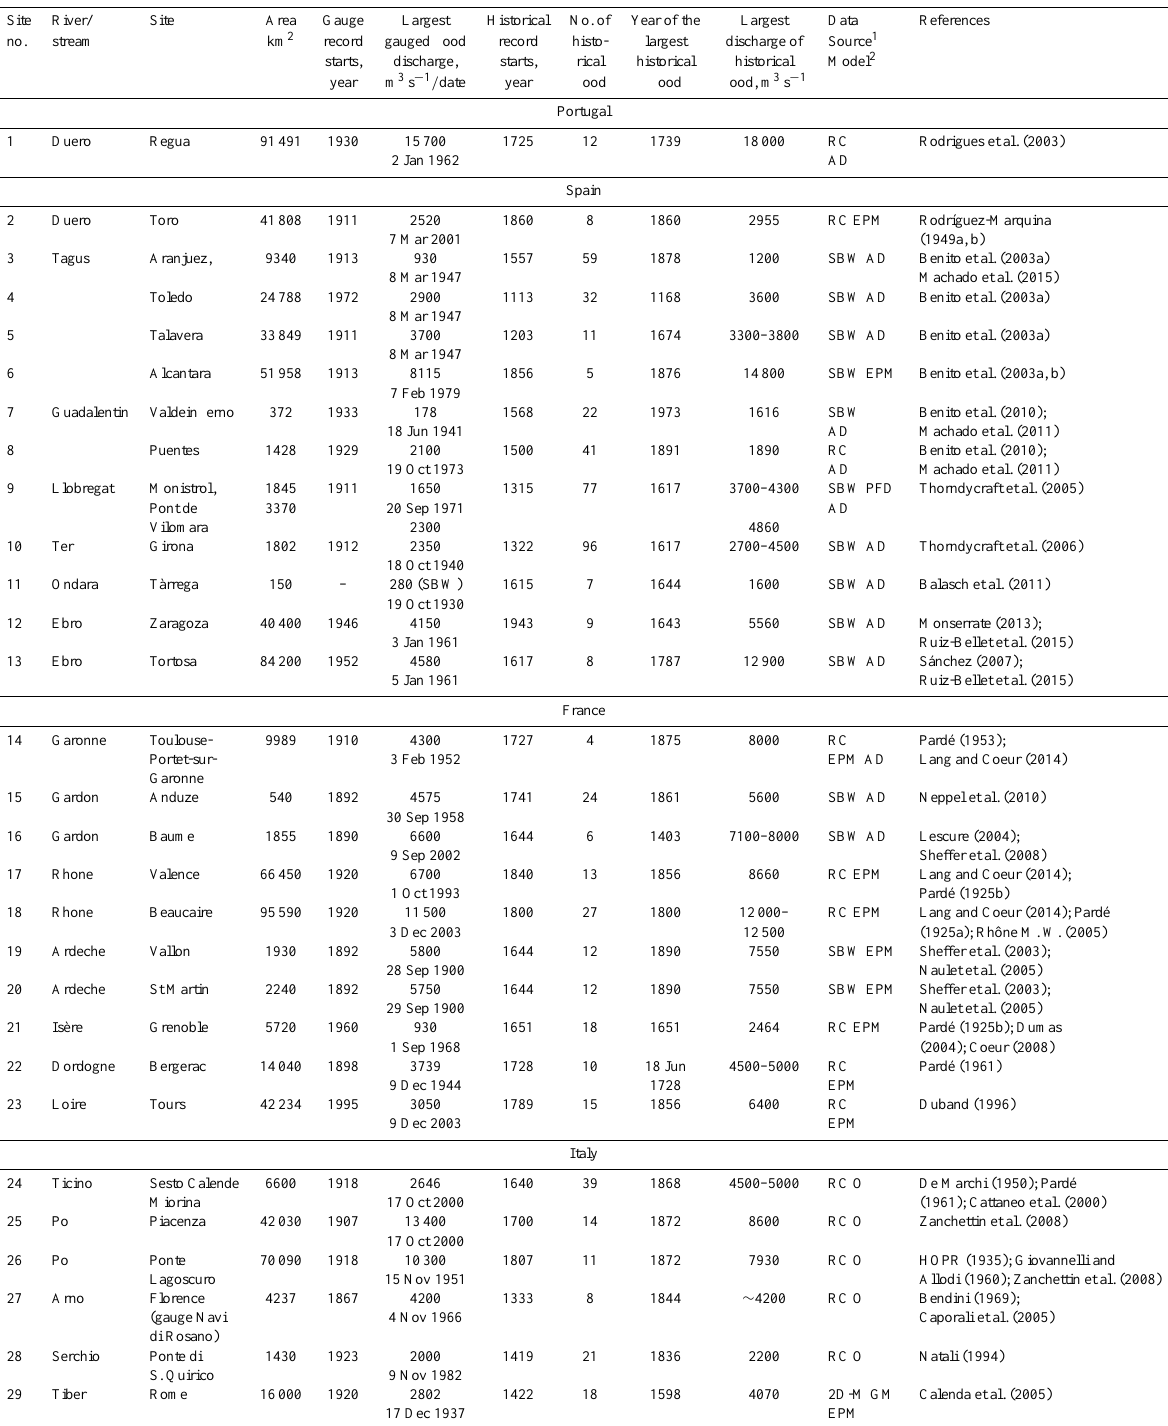
Table 1. Summary of historical discharge estimates for selected rivers in Europe. Only sites with multiple historical flood records in the recent literature are included. Additional discharge data of individual pre-instrumental floods can be found in Pardé (1961) and Francou and Rodier (1967). Legend: 1: main documentary data source: EPM – epigraphic marks; O – observed flood levels; AD – archival descriptions; PFD – palaeoflood deposits; FC – flood categories. 2: discharge estimate method: RC – from rating curve; GM – Gauckler–Manning equation; CEq – Chézy equation; SBW – step-backwater method; CD – critical depth; 2D-M – bidimensional model; WLT – water-level transposition from the nearby gauge station; RRM – rainfall-runoff model; STA – statistical method. Flood discharge re-estimated in 3900m 3 s − 1 (Kirsch and Pohl,